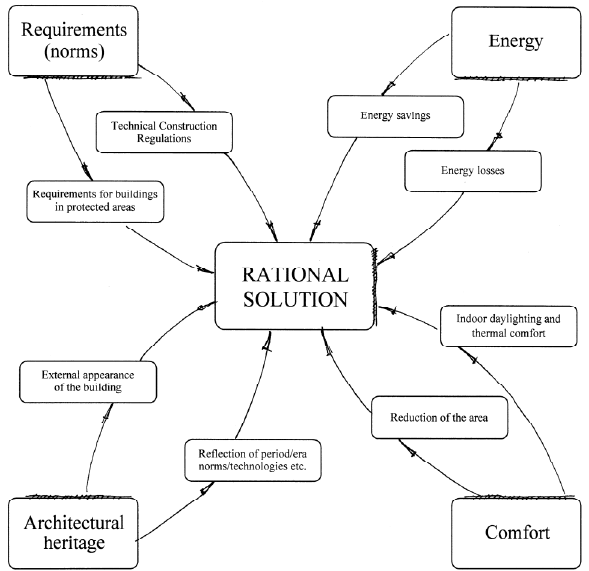
Fig. 2. Consistency between four components while seeking for sustainable development of old vernacular architecture Criteria for ranking the variants of building renova- tion are presented in Table